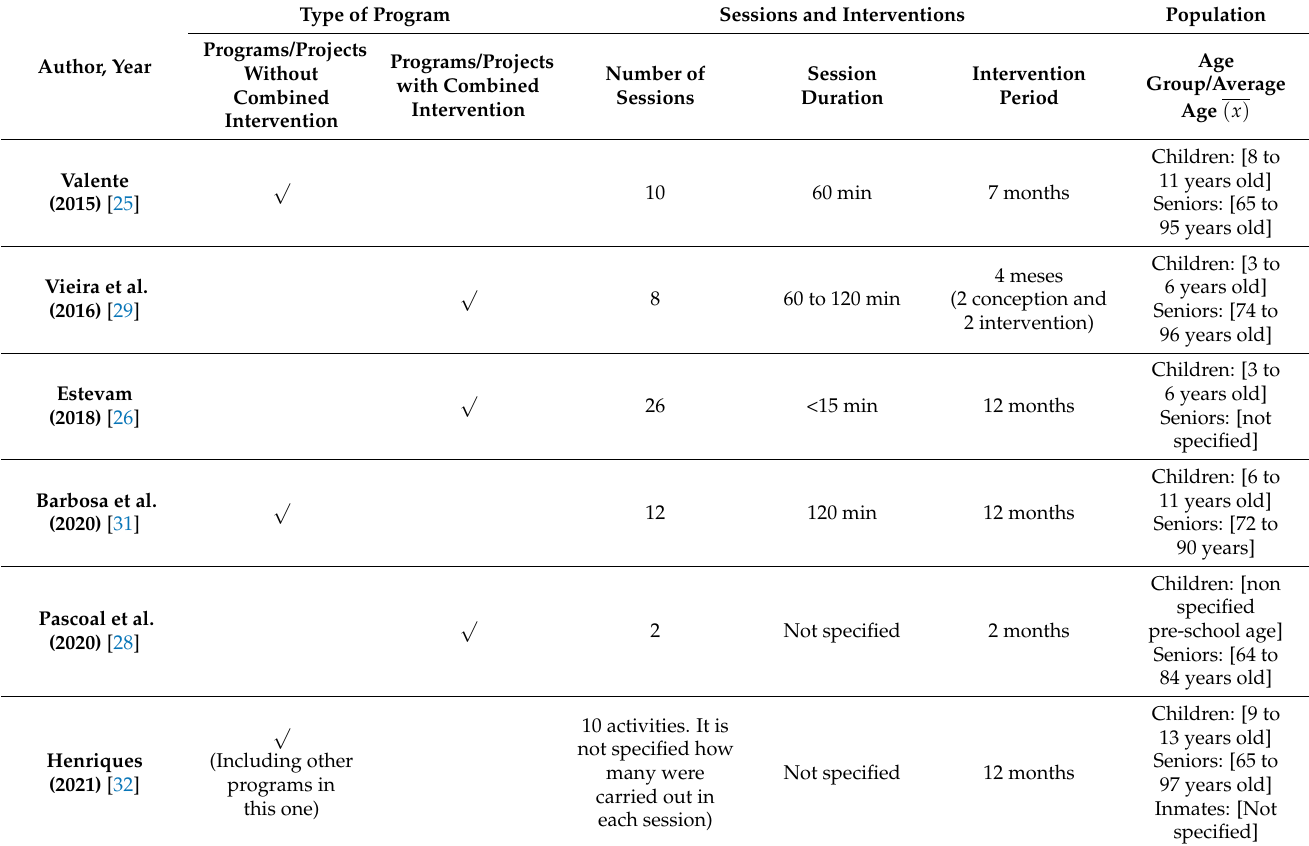
Table 2. Synthesis of the program’s/project’s characteristics in the scope of intergenerationality.